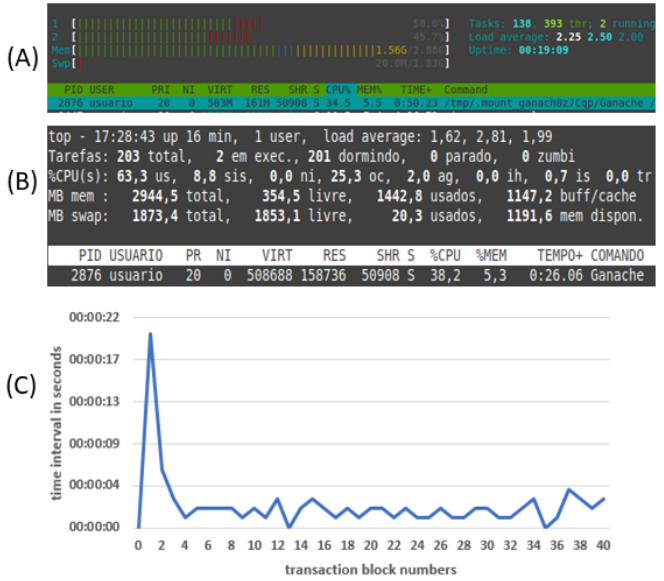
Figure 14. Figures ( A ) and ( B ) show top and htop indicating CPU time and ( C ) transaction time in Ganache at layer